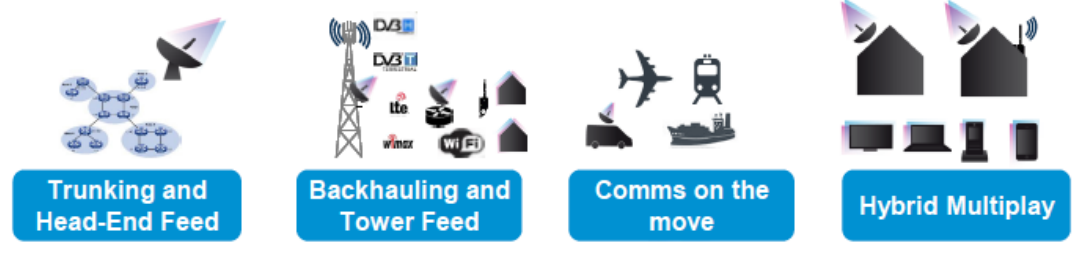
Figure 3. Satellite use cases